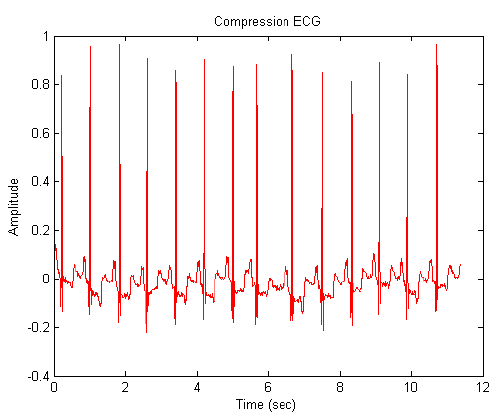
Figure 7. The ECG signal after